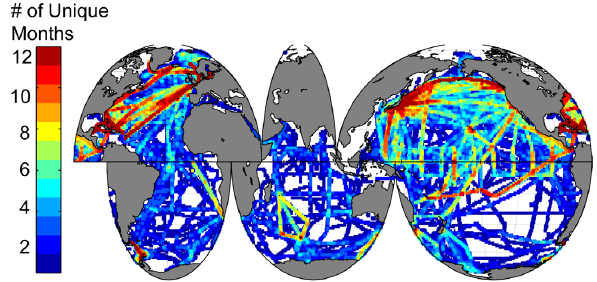
Figure 5. The number of unique months with f CO 2 observations in each grid cell between 1970 and 2007. White spaces indicate no